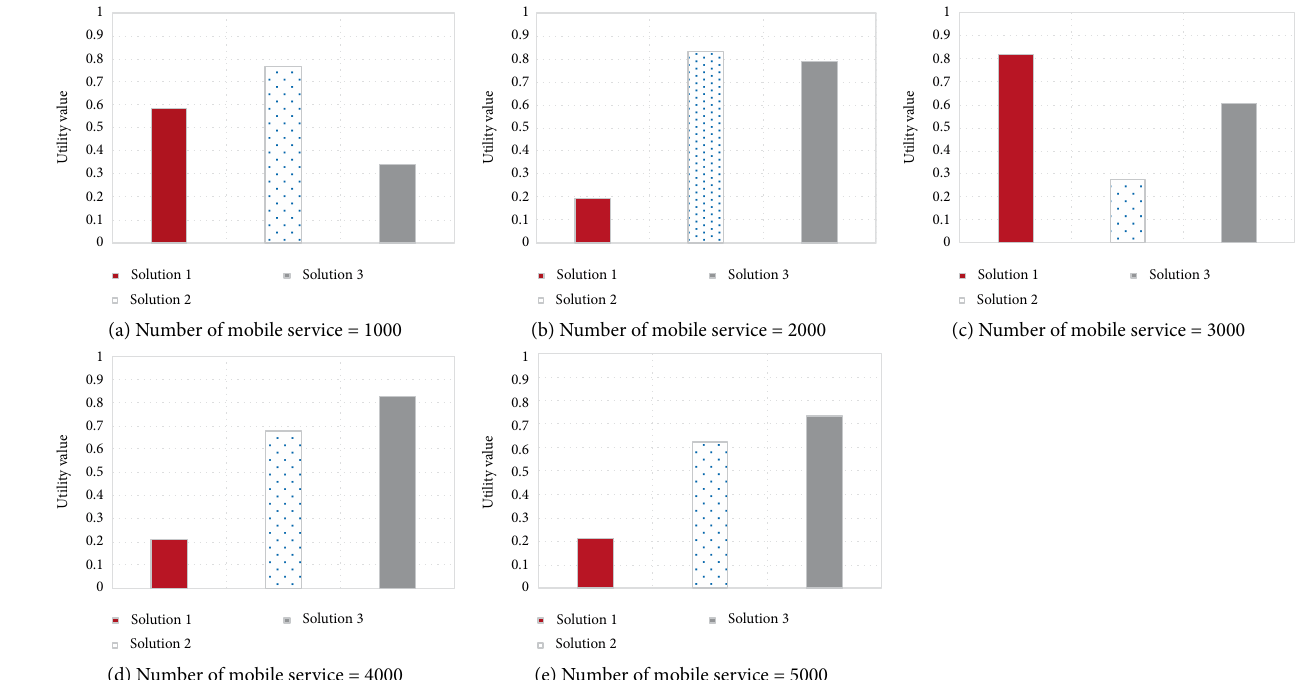
Figure 5: Comparison of the utility value of solutions at different mobile service scales.